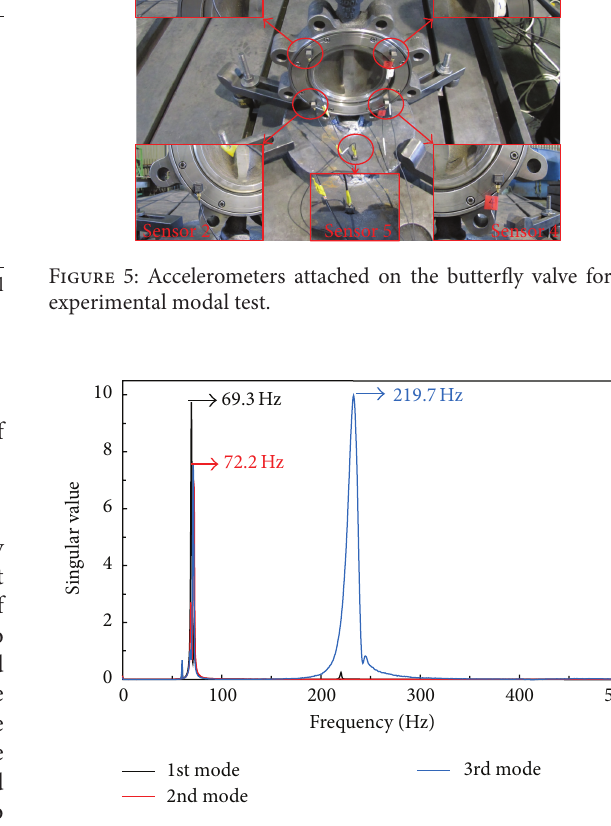
Table 1: Comparison of natural frequencies obtained using initial and modified FE-models. Natural frequency obtained from the experimental Natural frequency obtained